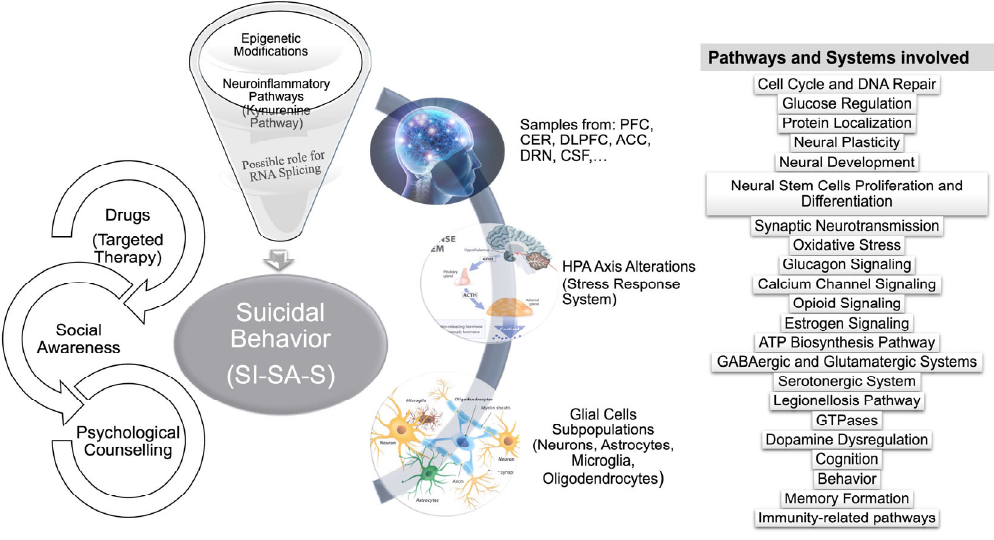
Figure 4. Aspects of suicidal behaviour: phenotypes, altered brain regions, pathways/systems involved, and therapeutic procedures.